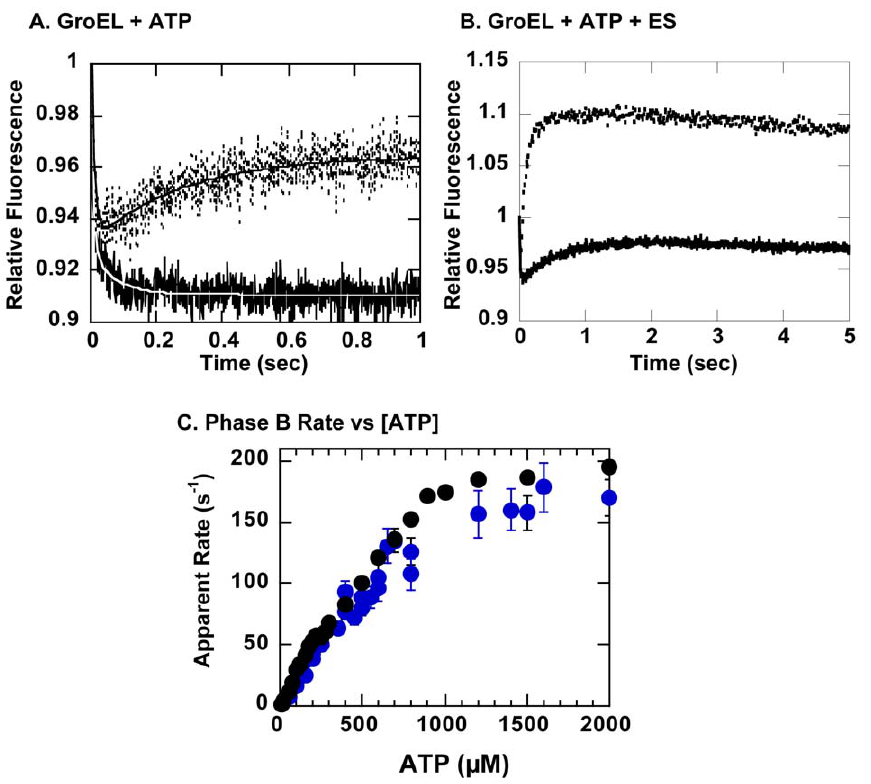
Figure 5. Stopped-flow fluorescence analysis of GroEL R231W and GroEL CP376-RW. Experiments were performed at 25 u C. Solid traces indicate changes in tryptophan fluorescence for CP376-RW and dotted traces indicate fluorescence changes for GroEL R231W. A. Changes triggered by addition of 1 mM ATP, B. changes triggered by addition of 1 mM ATP and an equimolar concentration of GroES heptamer. In A. , fits to the raw traces are also shown; in white for CP376-RW and in black for R231W. The kinetic constants derived from the fits are as follows: for CP376-RW; k 1 = 145.8 6 13.2 s 2 1 , Amp 1 = 0.086 6 0.004, k 2 = 14.2 6 2.0 s 2 1 , Amp 2 = 0.017 6 0.002. For R231W; k 1 =116.4 6 7.9 s 2 1 , Amp 1 = 0.076 6 0.003, k